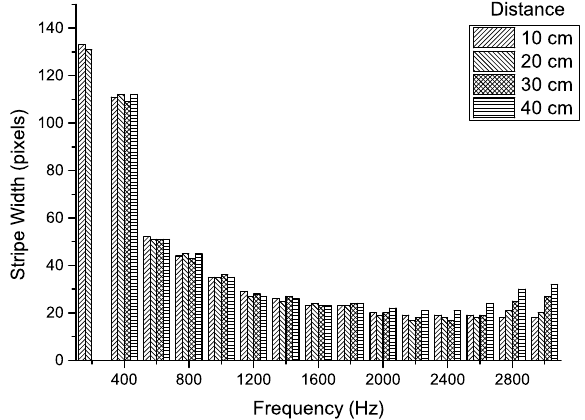
Figure 11. OOK Modulation Frequency vs. Stripe Width.